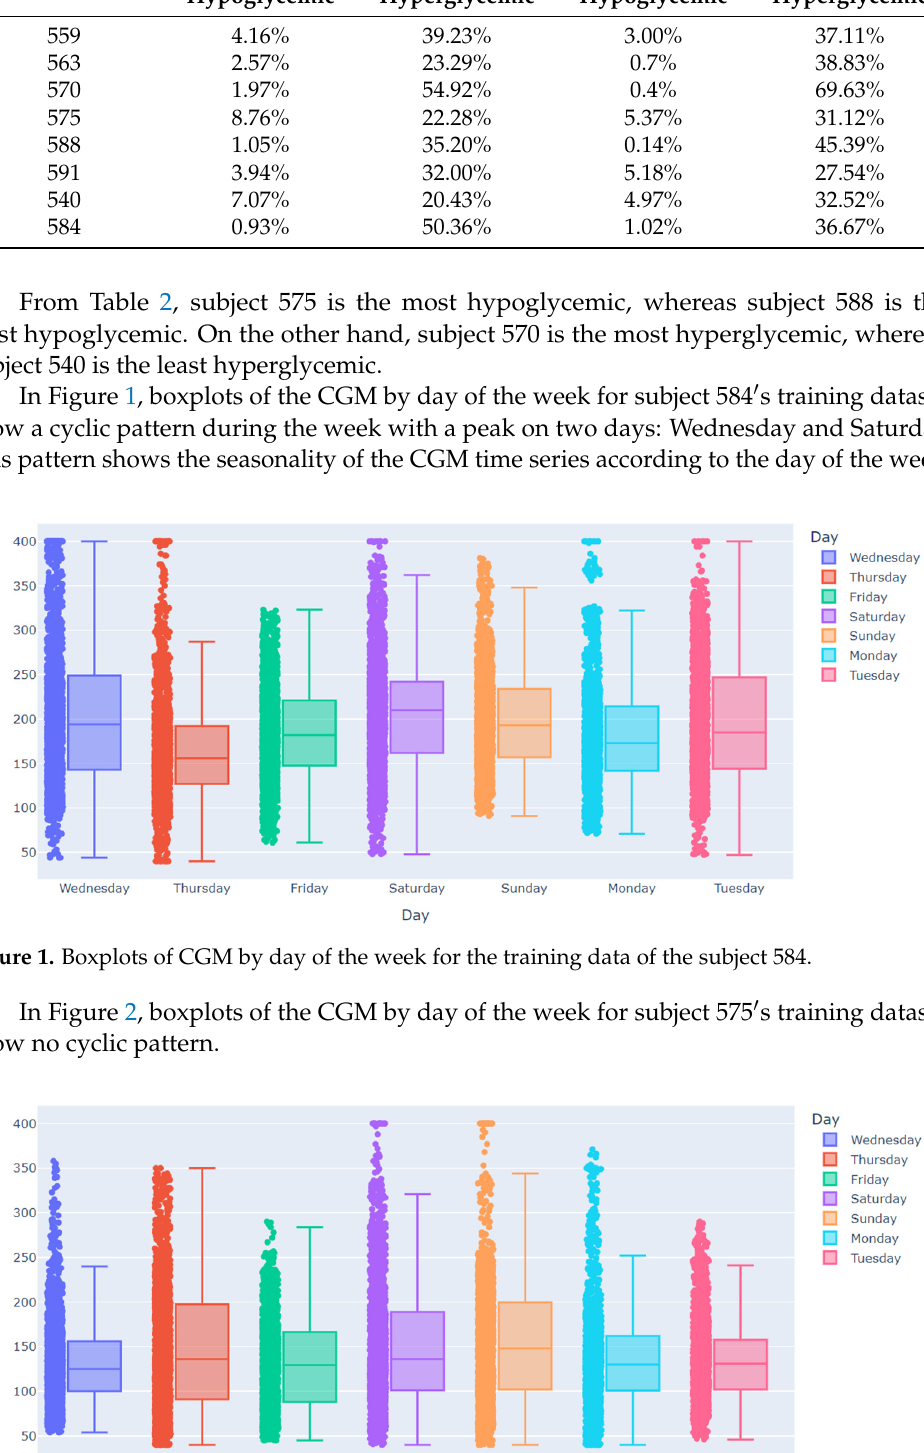
Figure 2. Boxplots of CGM by day of the week for the training data of the subject 575. In Figure 3, boxplots of the CGM by hour of the day for subject 570 ′ s training dataset show a cyclic pattern. This implies non-stationarity of the time series. Dataset 588 has a similar behavior, whereas datasets 584 and 591 also show some signs of non-stationarity.